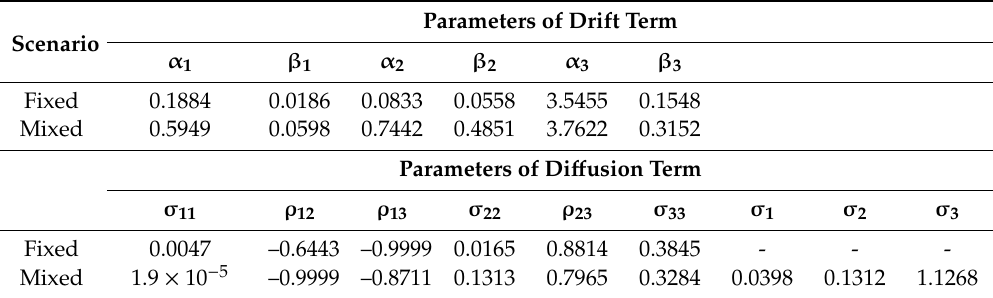
Table 12. Estimates of fixed-e ff ect